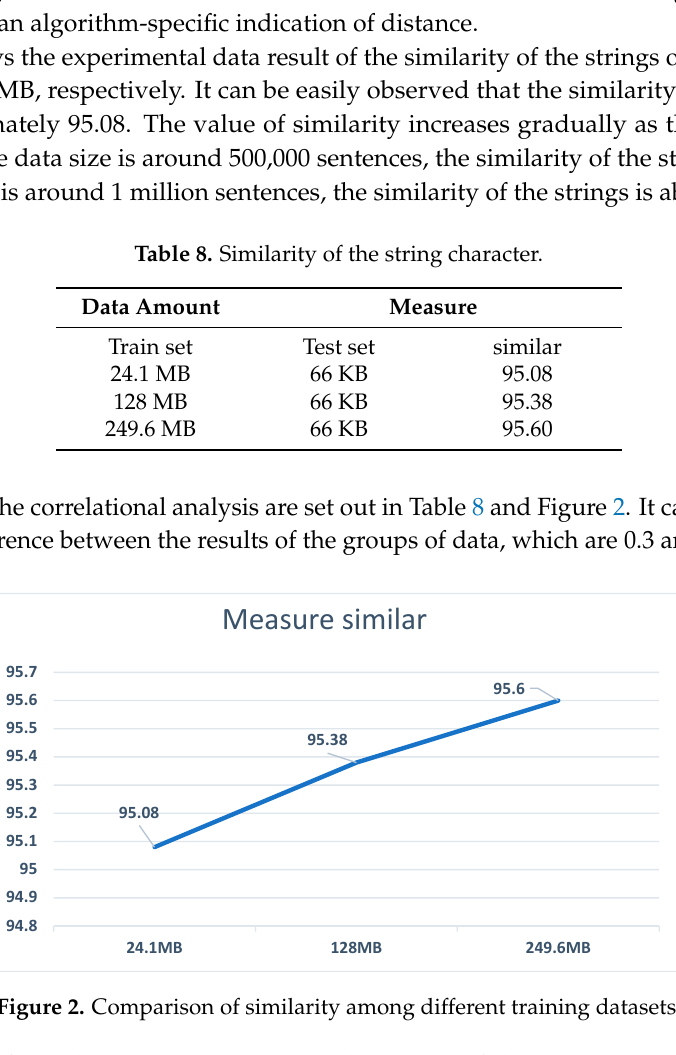
Table 9. Experimental results of all measure.